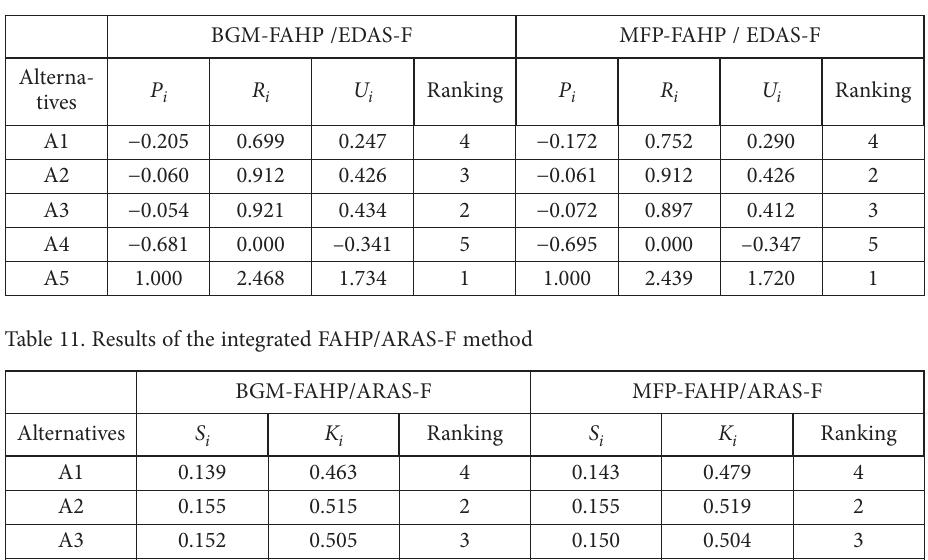
Table 10. Results of the integrated FAHP/EDAS-F method